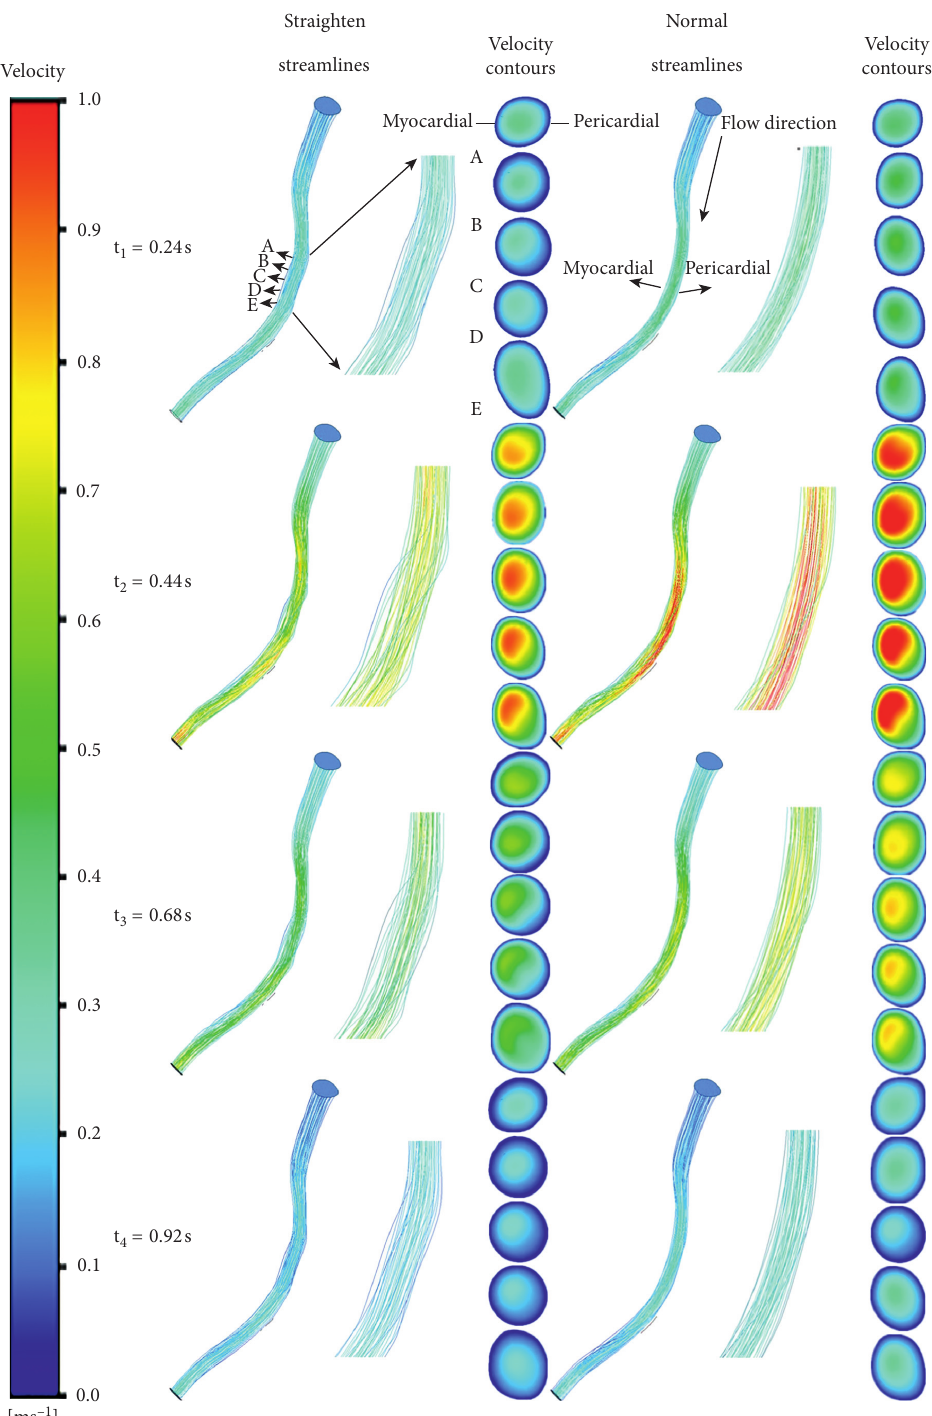
Figure 5: The streamlines near the left anterior descending coronary artery at four typical points with the various models. Cross sections are velocity contours in different moments of the different models. A, B, C, D, and E are selected from the models, and the first point is located at the inlet of the stented region. The distance between two points is 1mm, and these points are also shown. Slicing in these points along the direction perpendicular to the centerline forms the cross